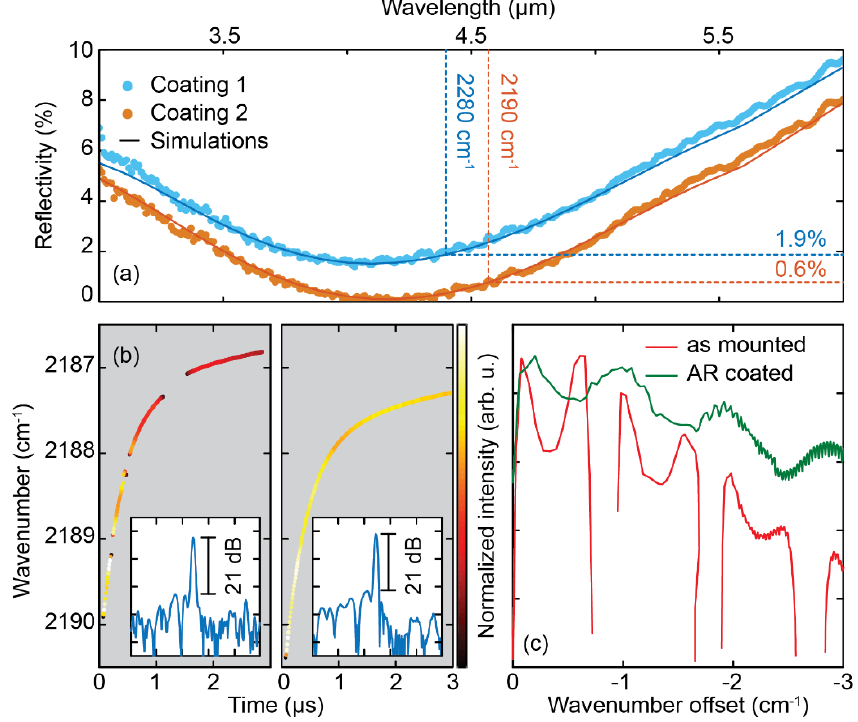
Figure 6. Effects of AR coating on dual section DFBs. ( a ) Reflectivity measurements of two coatings applied either to front and rear facet, respectively. The mismatch between the target wavelength and the minimum reflectivity are due to process uncertainties; ( b ) Mode maps of a dual-section DFB operated in iCW before and after AR coating. The spectra in the inset show that the SMSR is maintained after coating (inset); ( c ) Mode intensity as a function of frequency offset extracted from the mode maps in (b), before and after coating.